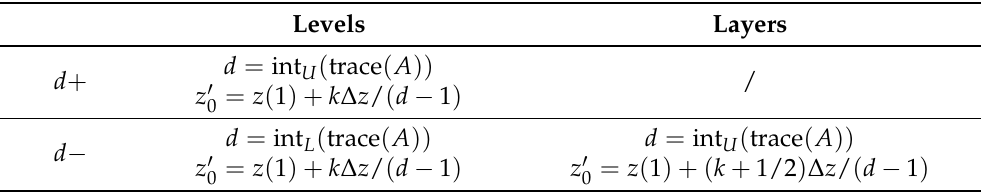
Table 1. Definition of the rounded number of degrees of freedom of a retrieval d and the initial guess z (cid:48) for the vertical levels or layers of the information-centered representation, with k going from 0 to 0 d − 1 for level representations, and from 0 to d − 2 for layer representations.